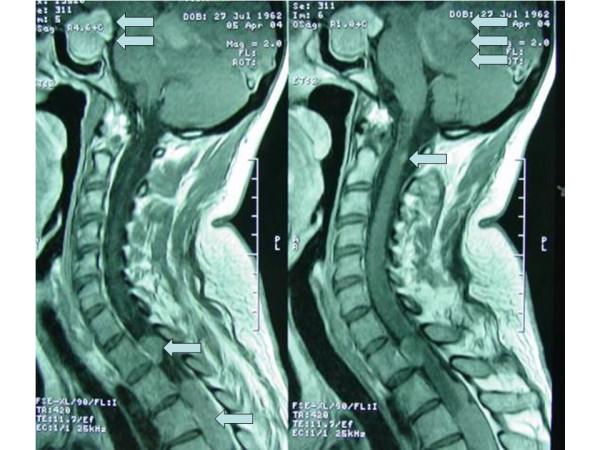
T1-weighted MRI: Tumors of the cervical and thoracic cord (single arrow). In addition, the tumors of the sellar turcica (double arrow) and cerebellum (three arrows) are depicted.